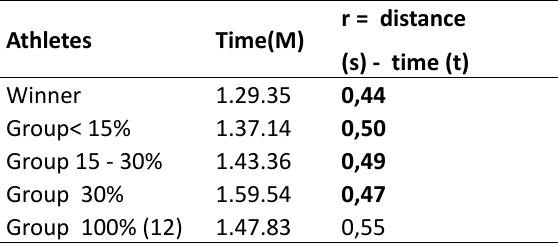
Table 1 . Finish times (t) of the leader in each group of athletes of 20 km of the race walking and their relation (r) with the distance travelled (s) in individual sections of the route.